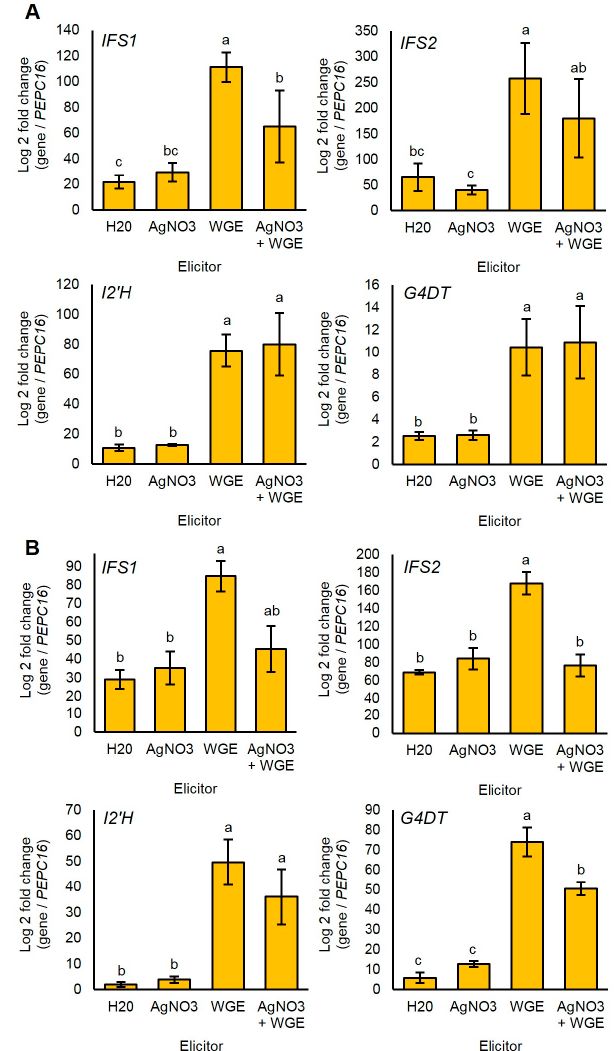
Figure 5. ( A ) Relative gene expression levels 48 h after elicitor treatment with elicitor measured by qRT-PCR; ( B ) Relative gene expression levels at 8 h after elicitor treatment. Expressions in each sample were measured relative to the endogenous reference gene PEPC16 . Two-way ANOVA, Tukey post hoc test, p < 0.01. Two independent experiments with four biological replicates were conducted with similar results. Different letters show significant differences by ANOVA